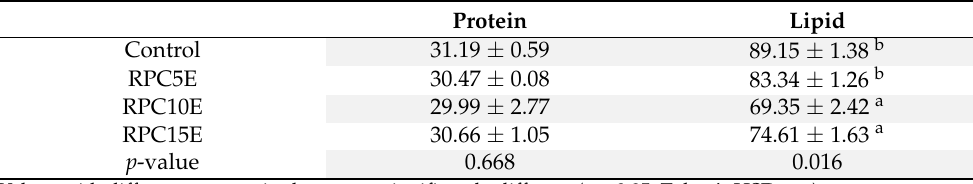
Table 6. Nutrient retention in whole body of fish (%).